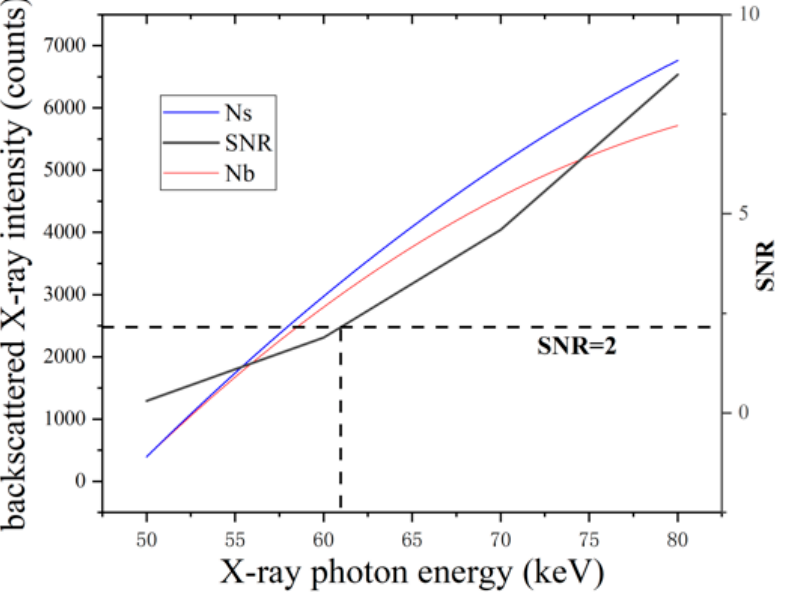
Figure 12. The e ff ect of X-ray energy on detection. SNR: signal-to-noise Figure 12. The effect of X-ray energy on detection. SNR: signal-to-noise ratio.